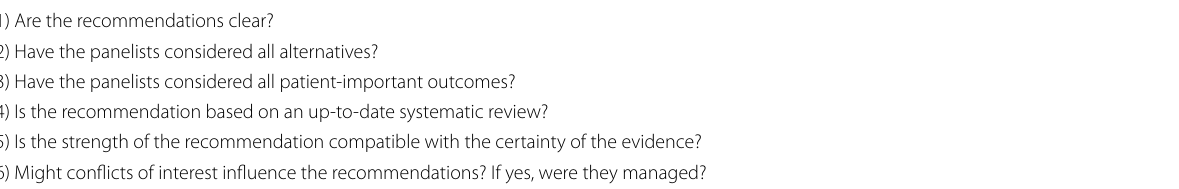
Table 1 Six questions to assess a guideline’s trustworthiness (1) Are the recommendations